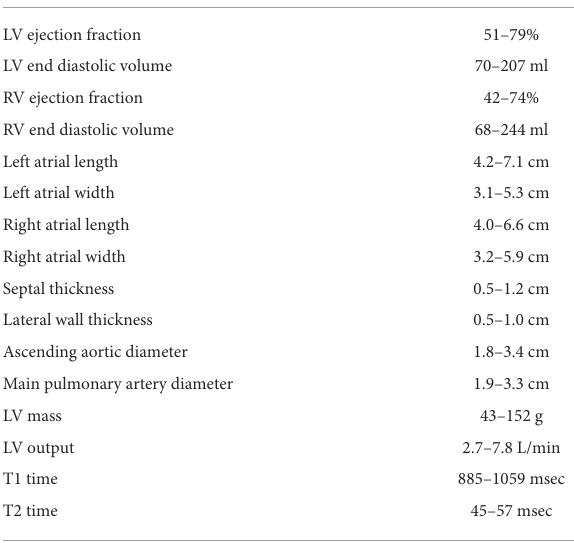
TABLE 1 Definitions of normal ranges for cardiac MRI domain components. Ranges from Kawel-Boehm et al.